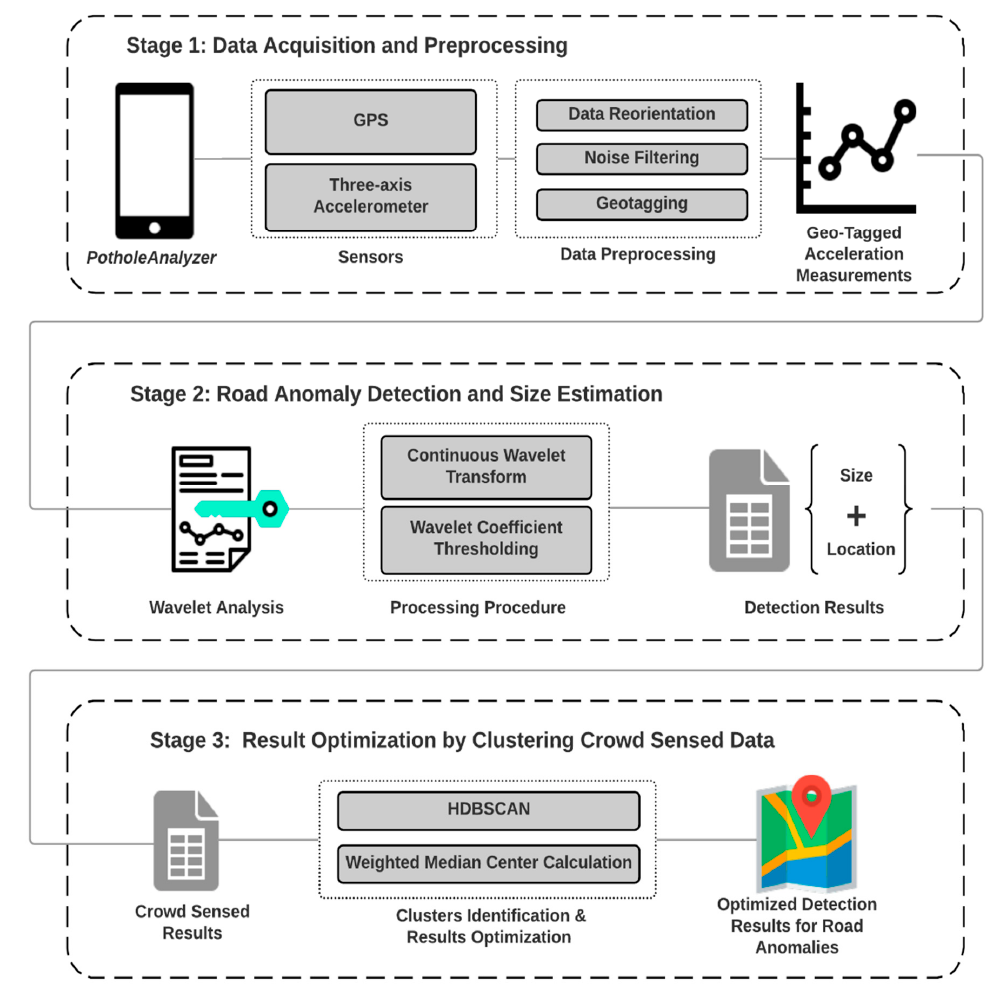
Figure 1. Research workflow.